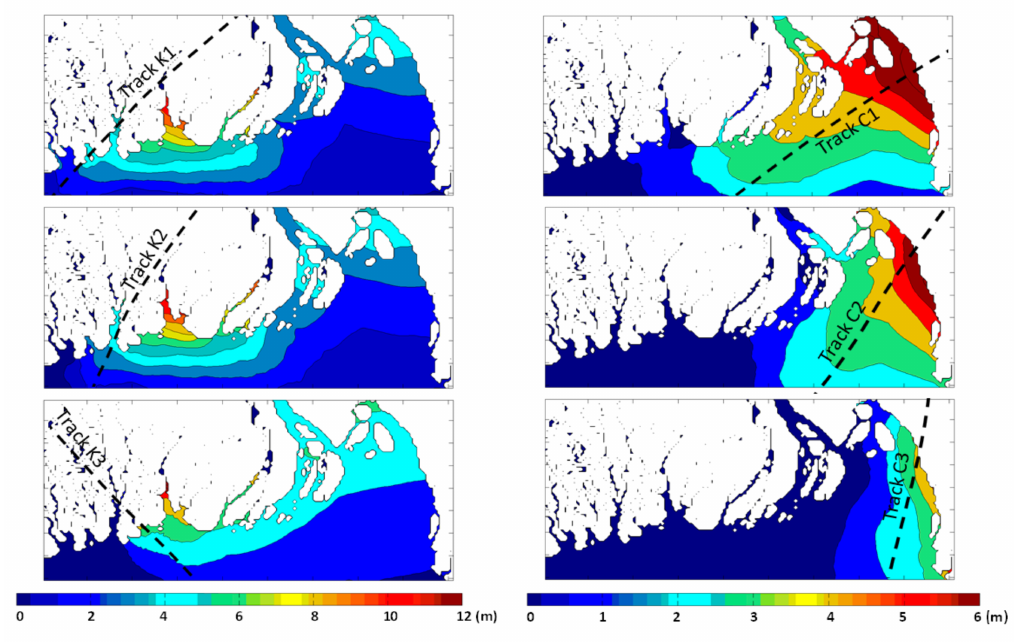
Figure 13. Spatial distribution of maximum surge height (m) for “surge-only” cases for Tracks K1–3 at the Khulna coast ( left panel ) and for Tracks C1–3 at the Chittagong coast ( right panel